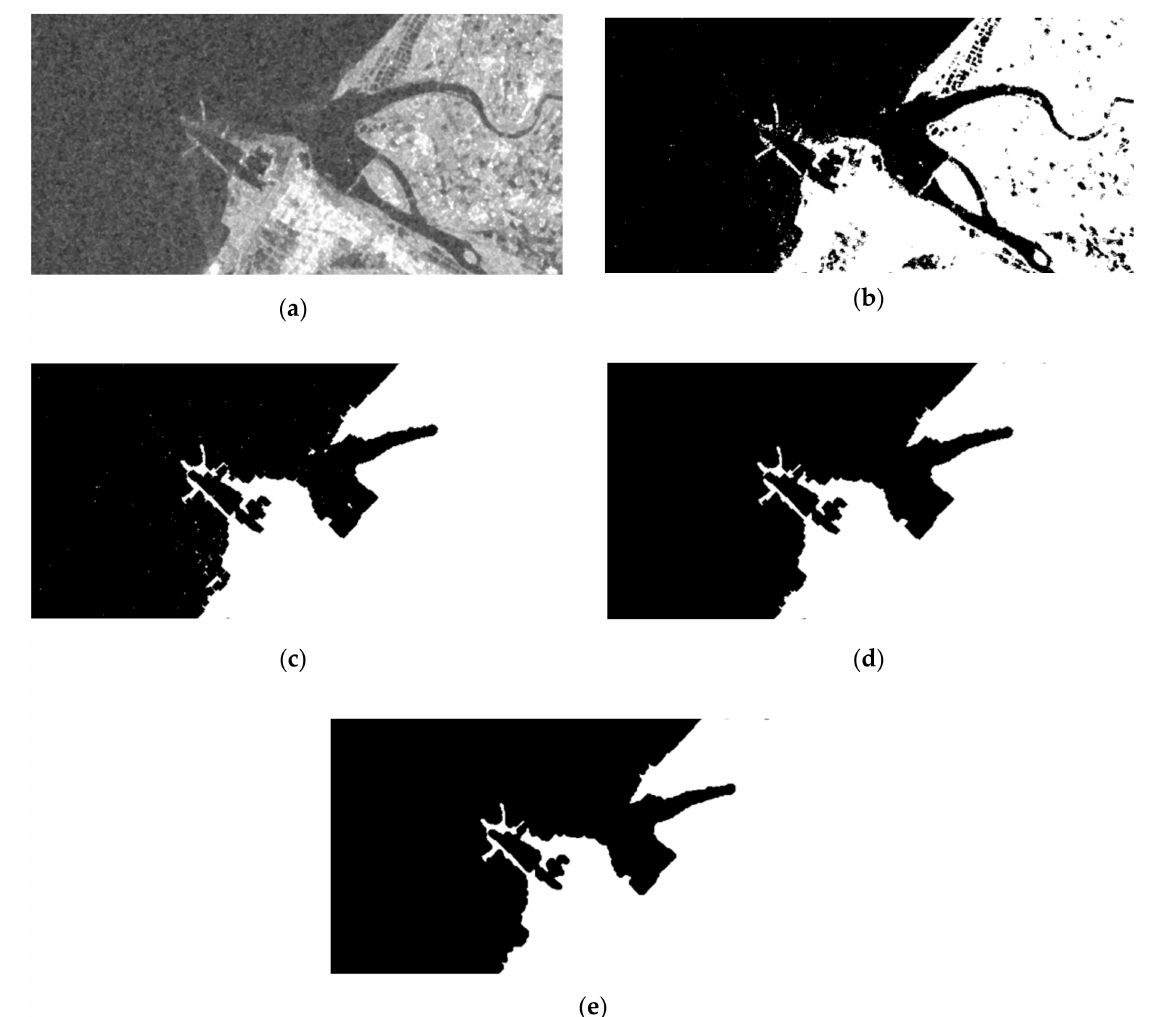
Figure 2. The processing of training labels. ( a ) original SAR image; ( b ) thresholding result; ( c ) remove small objects on land; ( d ) remove small objects in the sea; ( e ) and final smoothing